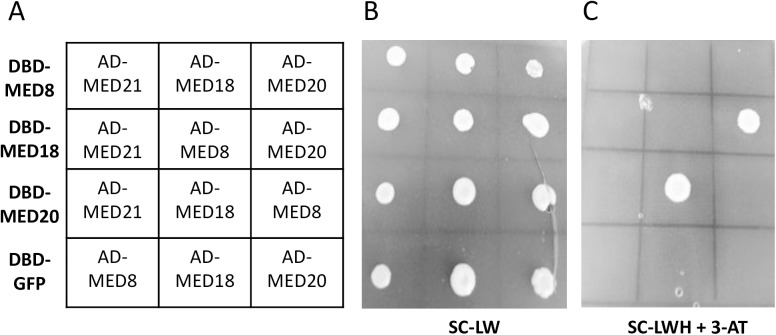
MED18 and MED20 interact in Yeast-2-Hybrid experiments.GAL4 DNA-Binding Domain (DBD-) plasmids and GAL4 Activation Domain (AD-) plasmids were co-transformed into S. cerevisiae and plated onto synthetic complete medium lacking Leucine and Tryptophan (SC-LW) or synthetic complete medium lacking Leucine, Tryptophan and Histidine but containing 12.5mM 3-aminotriazole (SC-LWH +3-AT). The plate layout is shown in (A) where each row contains the same DBD-MED or DBD-GFP plasmid with the co-transformed AD-MED plasmid shown in the 3x4 grid. (B) The transformants plated on SC-LW. (C) The transformants plated on SC-LWH +3-AT showing reciprocal positive interactions between MED18 and MED20 plasmids. The experiment was repeated with independent transformations and showed the same result.